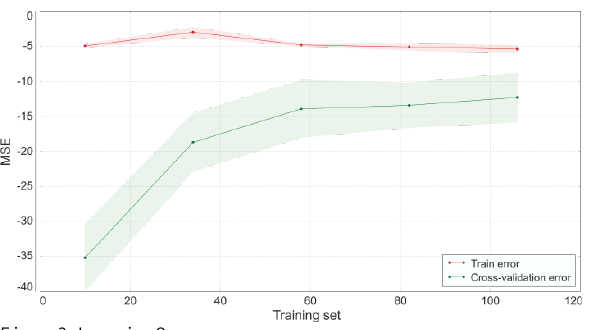
Figure 3: Learning